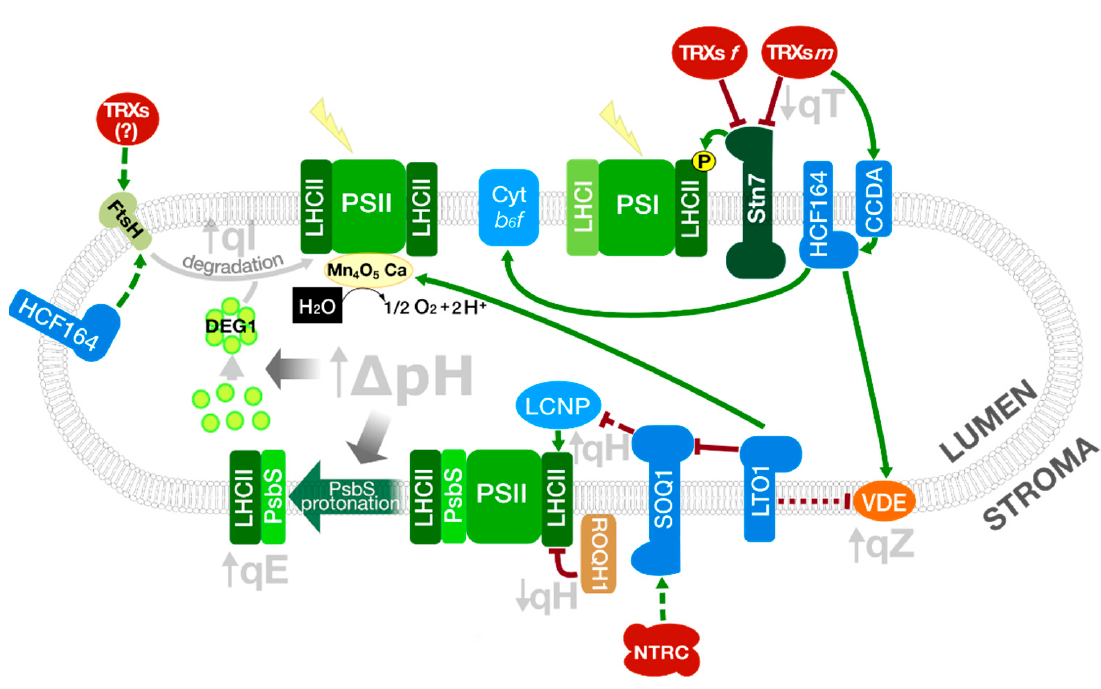
Figure 3. Regulation of the NPQ components in Arabidopsis chloroplasts. TRXs m are key redox players in the regulation of NPQ in plants as they transfer reducing equivalents into the thylakoid lumen through the proteins CCDA and HFC164. The thylakoid protein LTO1, with an oxidant role, contributes to maintaining the redox homeostasis in the chloroplast lumen. Green arrows represent activation mediated by TRXs or NTRC; truncated red lines, inhibition. A dashed line indicates a hypothetical interaction. Protein complexes were schematised for a better understanding.